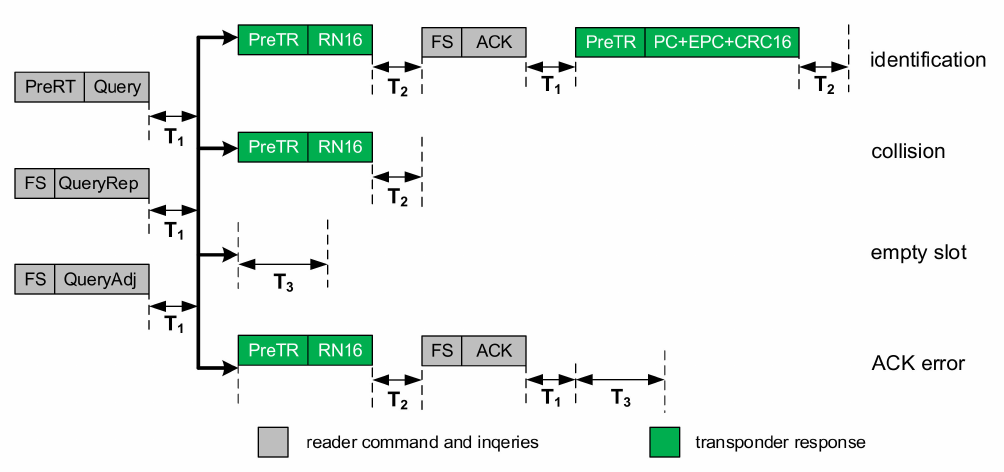
Figure 10. Inventory round: event types in a single round; construction of time slots in case of correct identification, data collision, empty slot, and NoACK in ISO